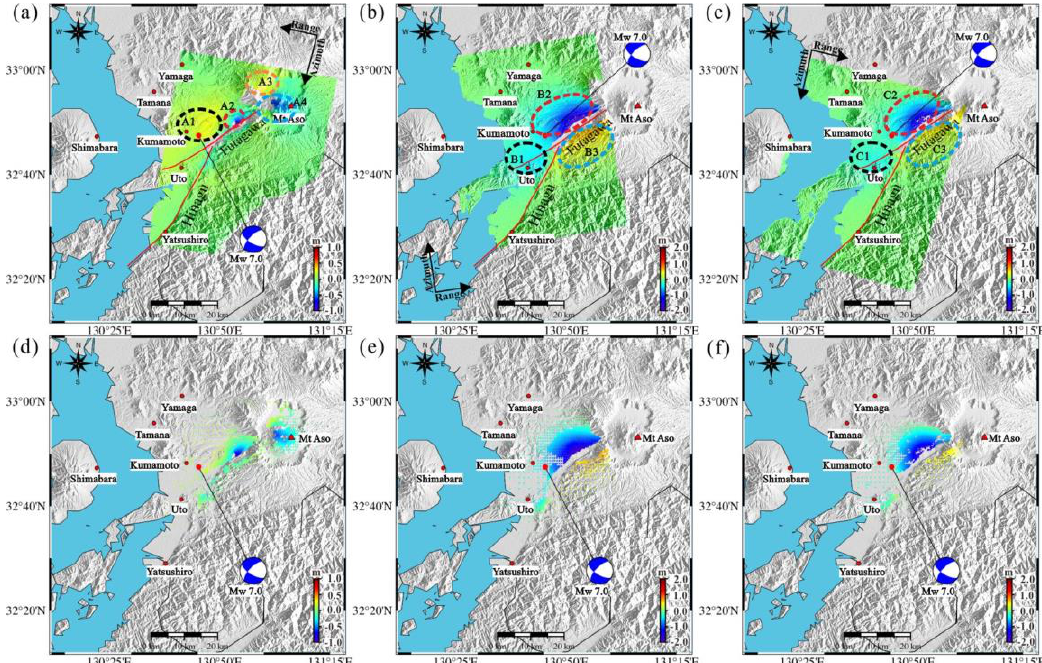
Figure 2. Coseismic surface deformation of the 2016 Kumamoto earthquake. Descending ( a ) and ascending ( b ) right-looking InSAR LOS surface deformation maps from PALSAR-2 images ( d ) and ( e ) the corresponding pixels after the quadtree down-sampling, respectively. Descending left-looking ( c ) and subsampled ( f ) InSAR coseismic deformation from DL track T29. Positive/negative values indicate the movement towards/away from the sensor along the line of sight.